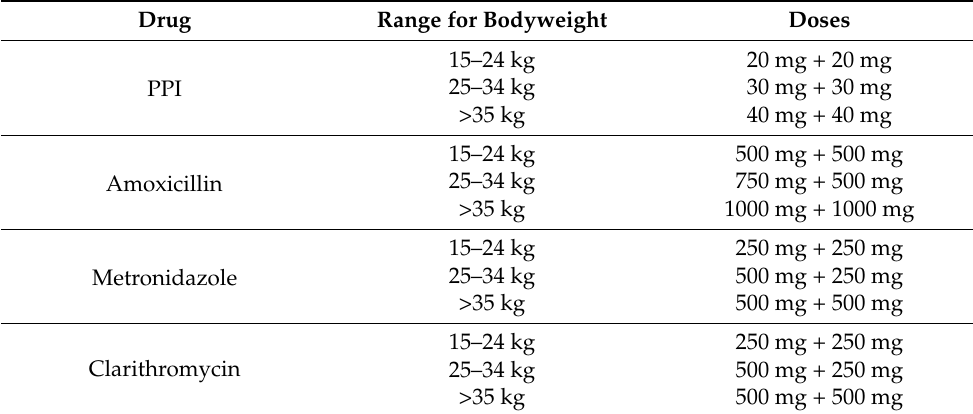
Table 2. Standard PPI and antibiotic prescription doses for body weight.